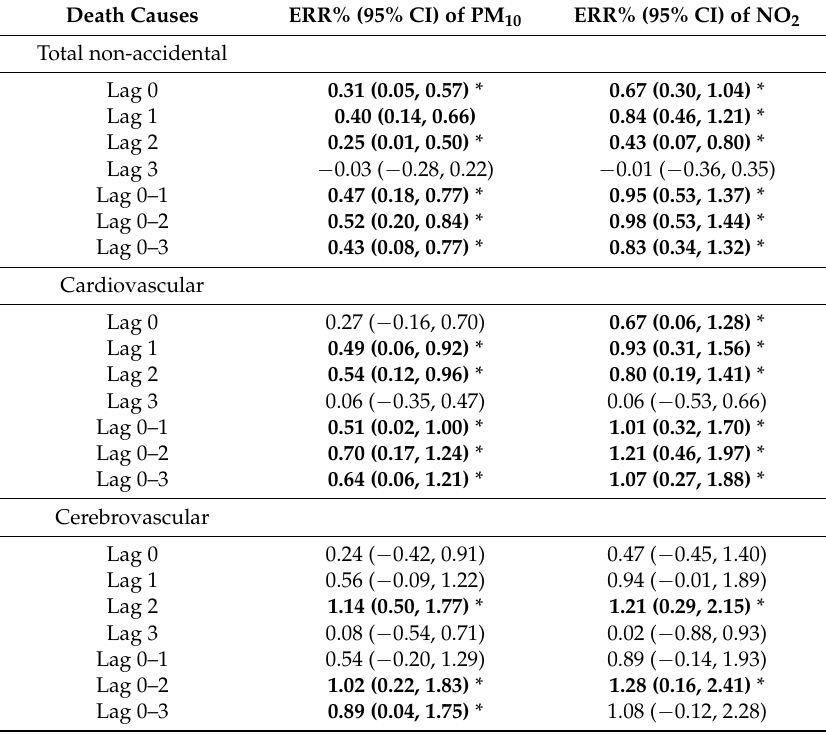
Table 3. ERRs (%) with 95% confidence intervals for mortality for each 10 µ g/m 3 increment in PM 10 and NO 2 concentrations at different lag